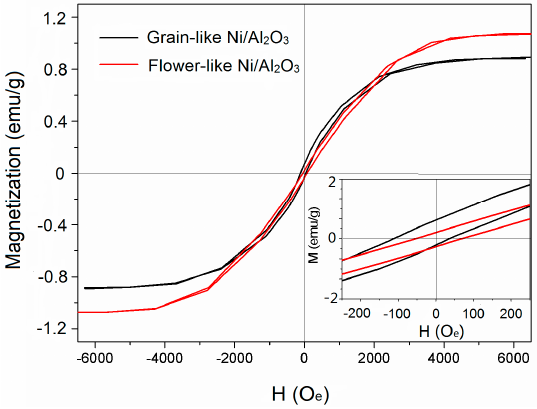
Figure 5. Hysteresis loop curves of flower-like and grain-like Ni/Al 2 O 3 /Ni films.